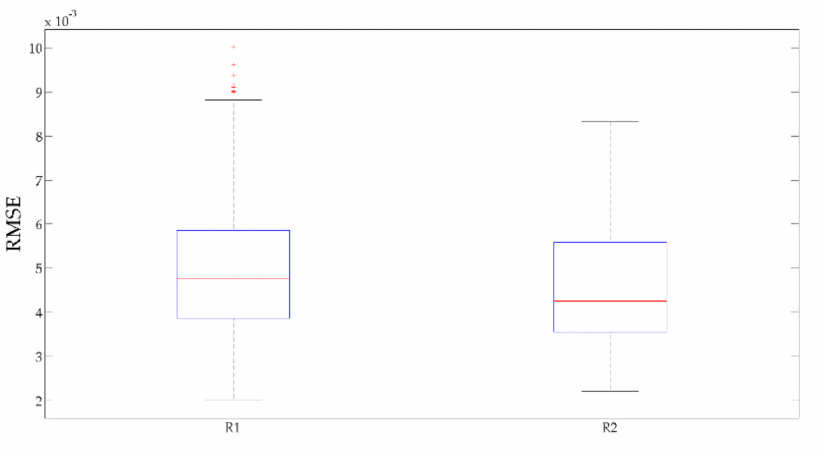
Figure 11. Estimation results of two routes for the case ship.